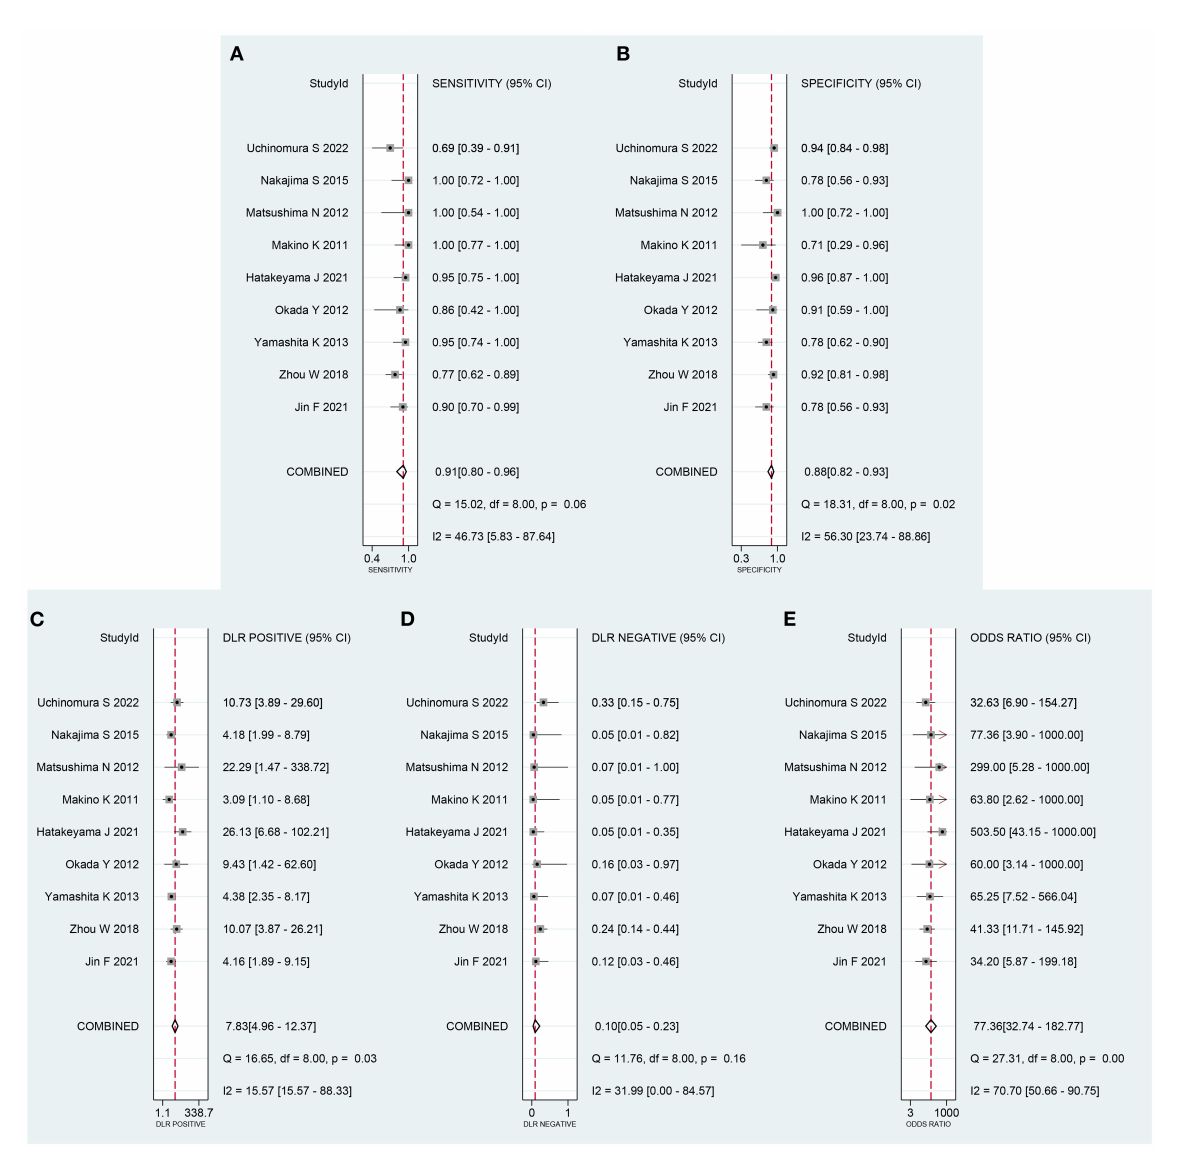
different parameters, respectively. In general, 18F-FDG-PET / CT has a good prospect in differentiating the above two